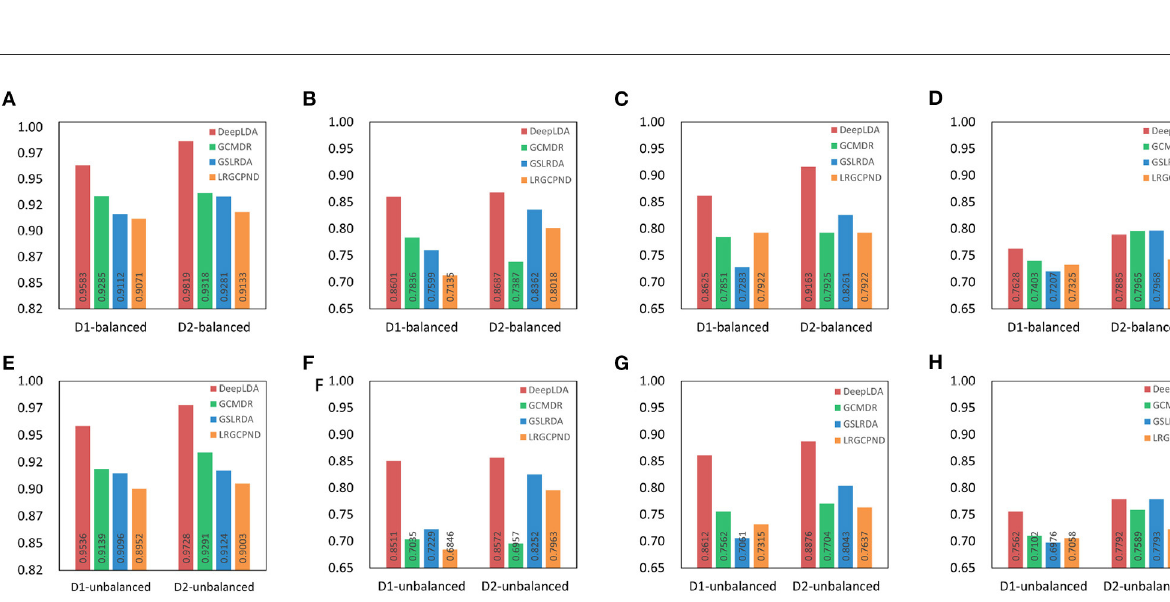
FIGURE6 Performance comparison with other methods on balanced and unbalanced datasets. D1 and D2 represent NoncoRNA and ncDR, respectively. (A) AUC on balanced datasets. (B) AUPR on balanced datasets. (C) F1-score on balanced datasets. (D) MCC on balanced datasets. (E) AUC on